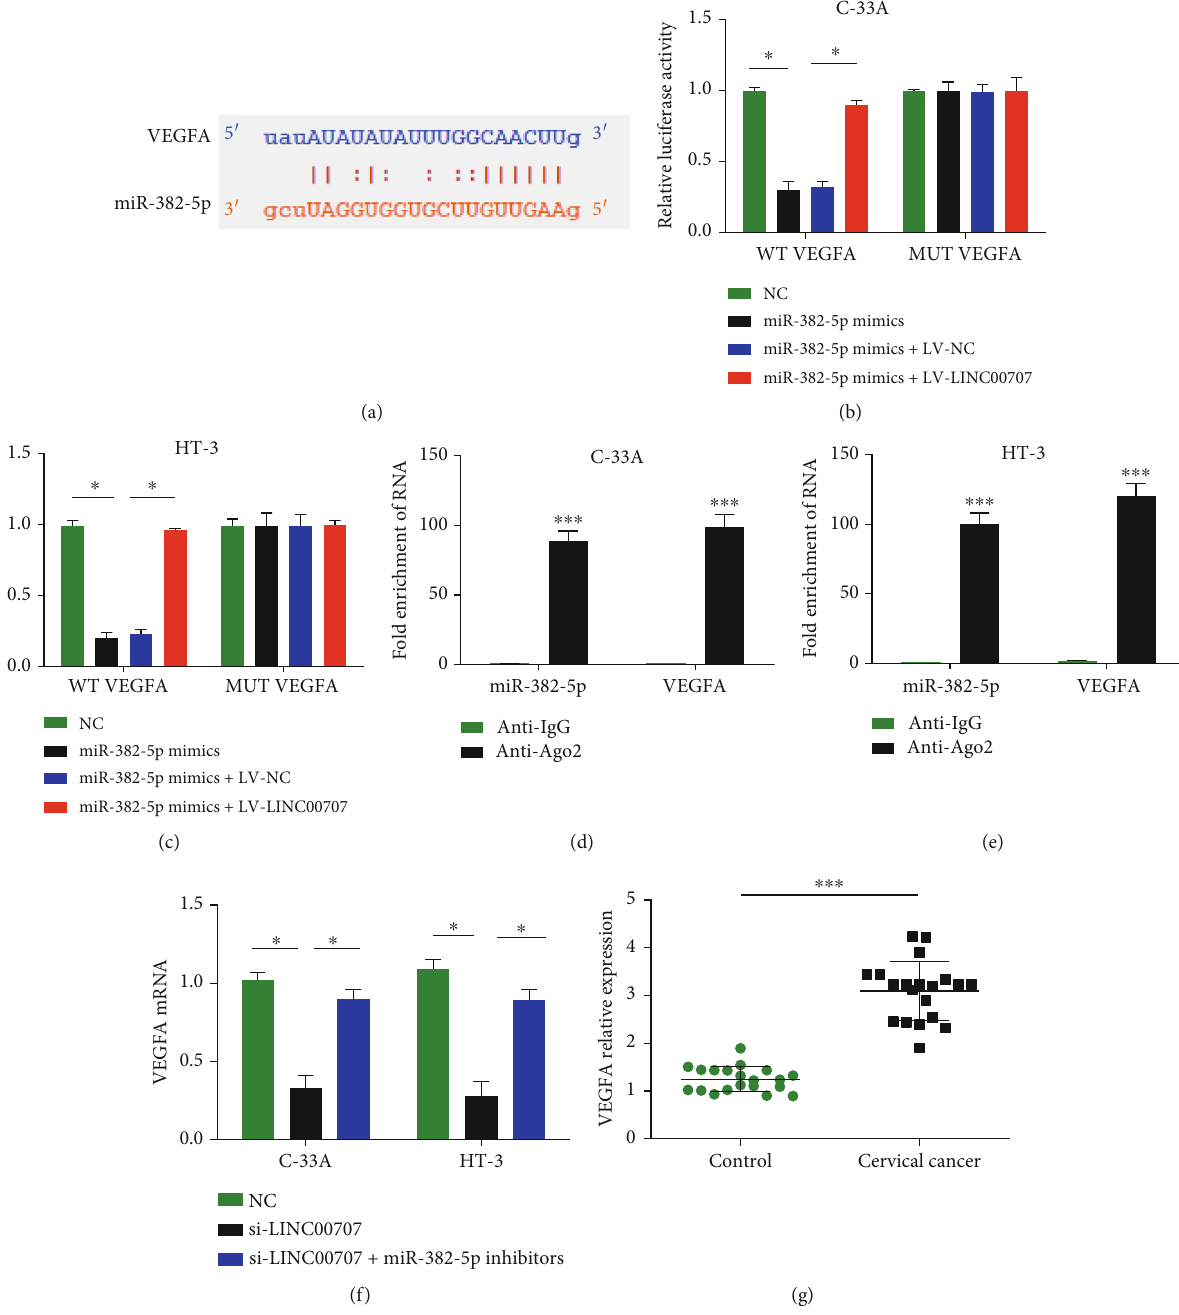
Figure 4: VEGFA was a target for miR-382-5p. (a) Binding regions between VEGFA and miR-382-5p. (b, c) Luciferase activity was evaluated in C-33A and HT-3 cells cotransfected with VEGFA-WT or VEGFA-MUT reporter and miR-382-5p mimics or LV-LINC00707. (d, e) RIP experiment was carried out to assess the interplay between VEGFA and miR-382-5p. (f) VEGFA mRNA expression in C-33A and HT-3